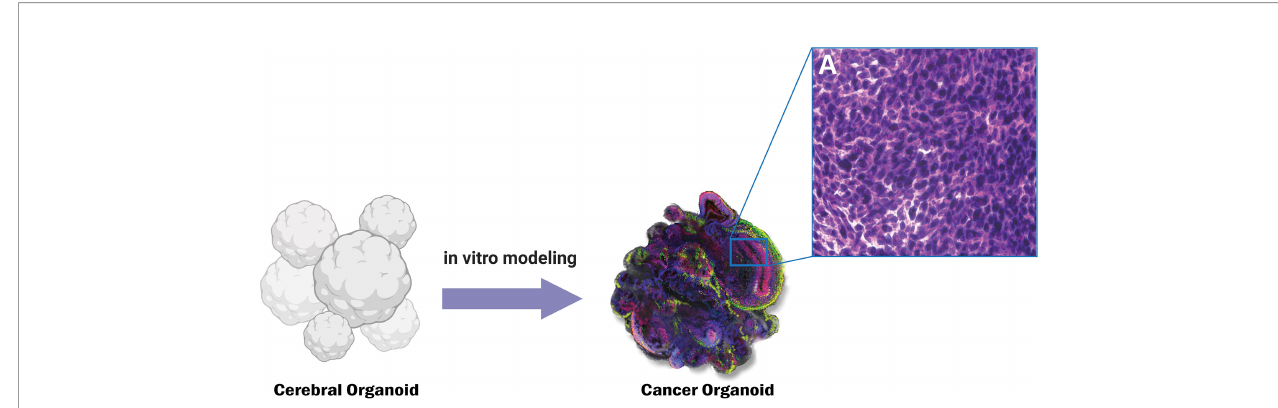
FIGURE 3 | Genetically engineered cancer organoids show histopathological similarity to CNS tumors such as Glioblastoma. Panel A shows the characteristic histopathological features of cancerous tissue such as increased nuclear to cytoplasmic